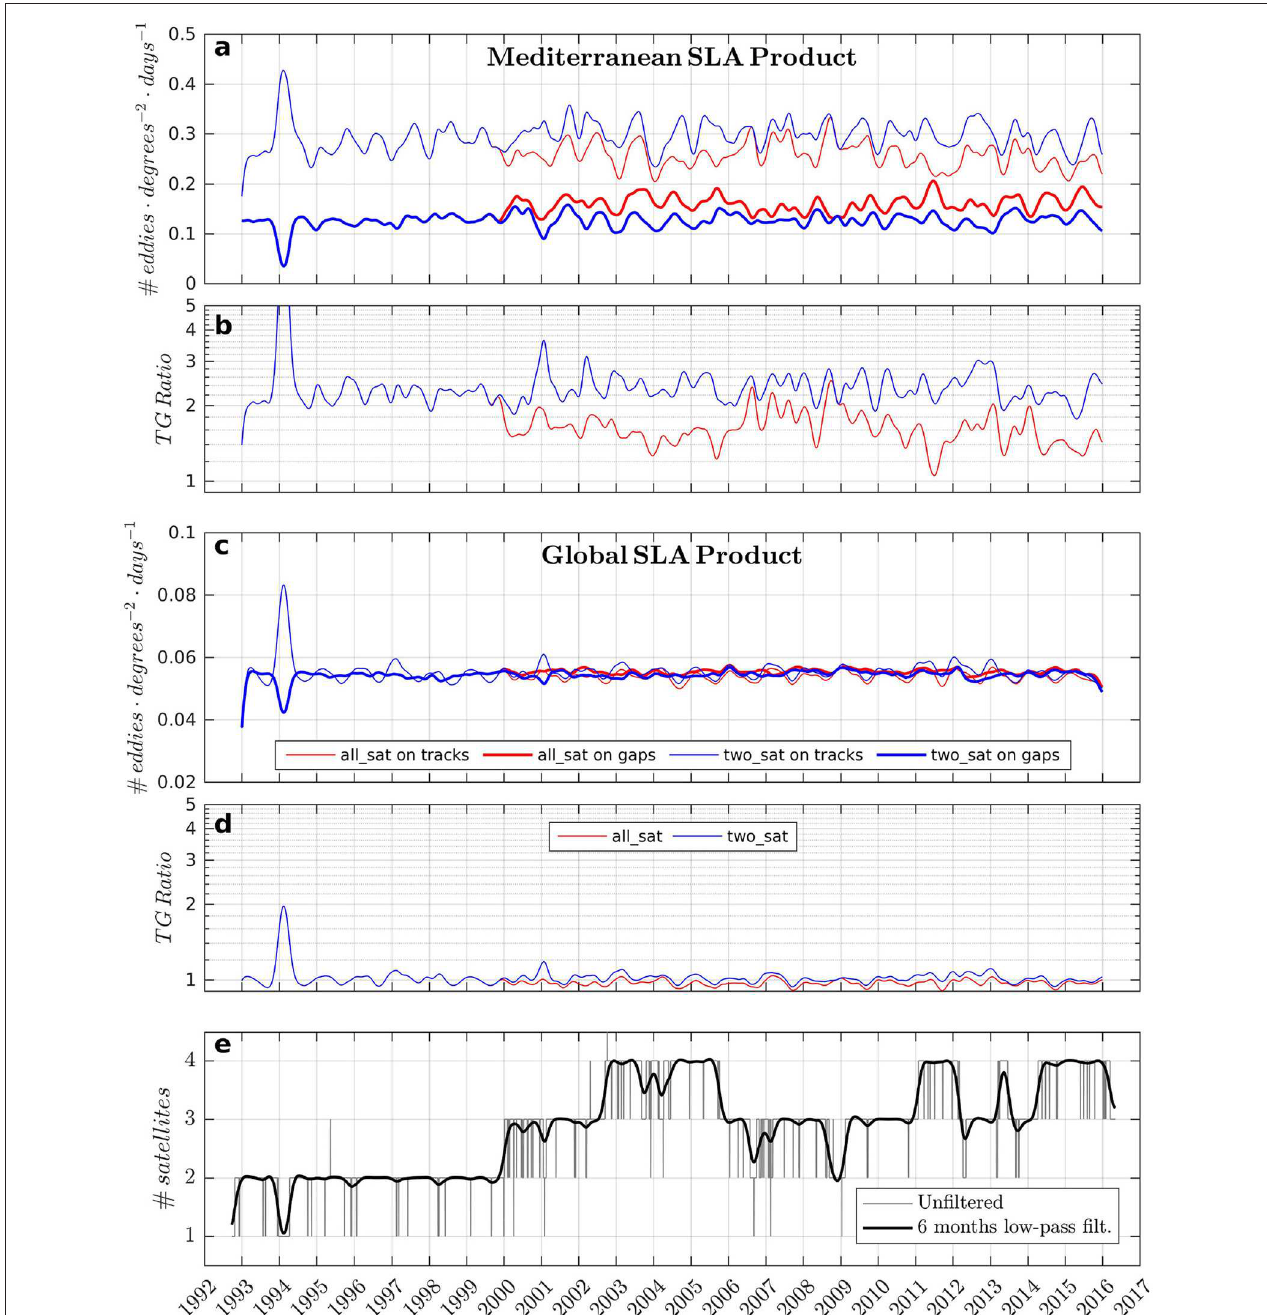
FIGURE 2 | (a) Six months low-pass filtered time series of the number of eddies on a 0.5 ◦ strip along the Topex/Poseidon tracks (thin lines) and in the gaps between the tracks (thick lines) for the Mediterranean Sea all satellites SLA product (red lines) and the two satellites SLA product (blue lines). (b) Ratio between the number of eddies on the satellite tracks and between the tracks for the all satellites product (red) and the two satellites (blue) for the Mediterranean Sea. (c,d) Same as (a,b) , respectively, but for the global SLA products distributed by Copernicus and for the whole global ocean. (e) Original (gray) and 6 months low-pass-filtered time series (black) of number of satellites operating at a given